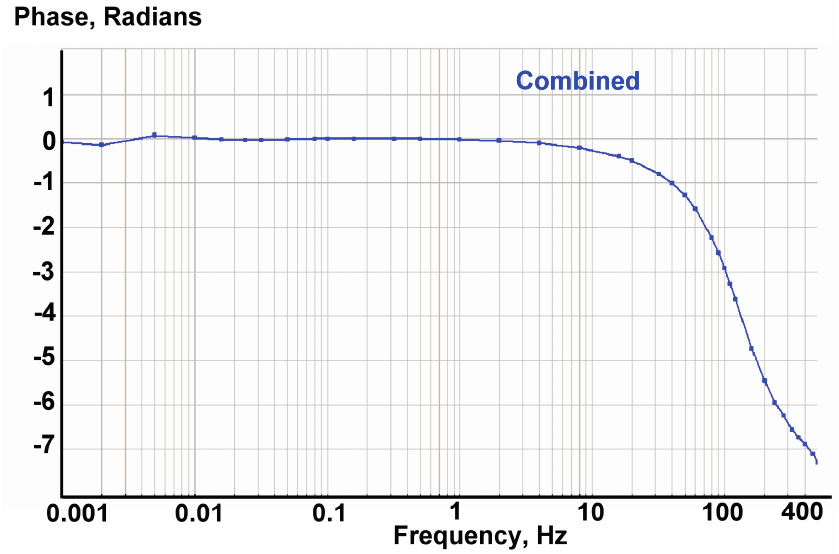
Figure 9. Simulated overall system phase